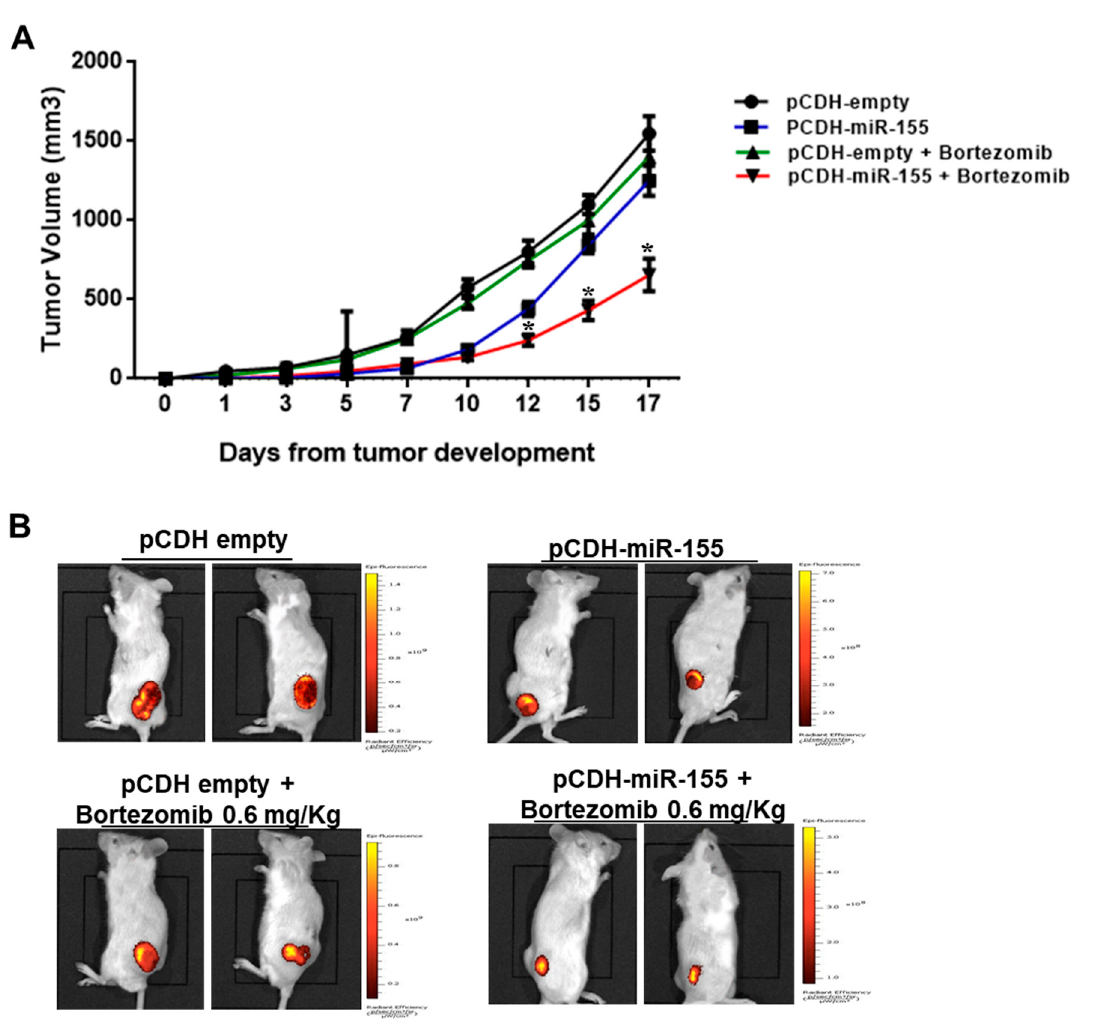
Figure 4. Enforced miR-155 expression enhances bortezomib activity against MM xenografts. ( A ) 2 × 10 6 of pCDH-miR-155 and 2 × 10 6 of pCDH-empty vector OPM-2-transduced MM cells were injected, respectively, in the right and left flank of a total of 10 CB-17 NOD-SCID mice. Tumor volume was measured in two dimensions by an electronic caliper, as detailed in materials and methods, every 2–3 days. At day 7, when the tumor volume of each group was approximately 100 mm 3 , mice were treated with 0.6mg/kg of bortezomib; * p < 0.05 with respect to pCDH-empty or pCDH plus bortezomib groups. ( B ) Representative IVIS Lumina pictures at day 13 are